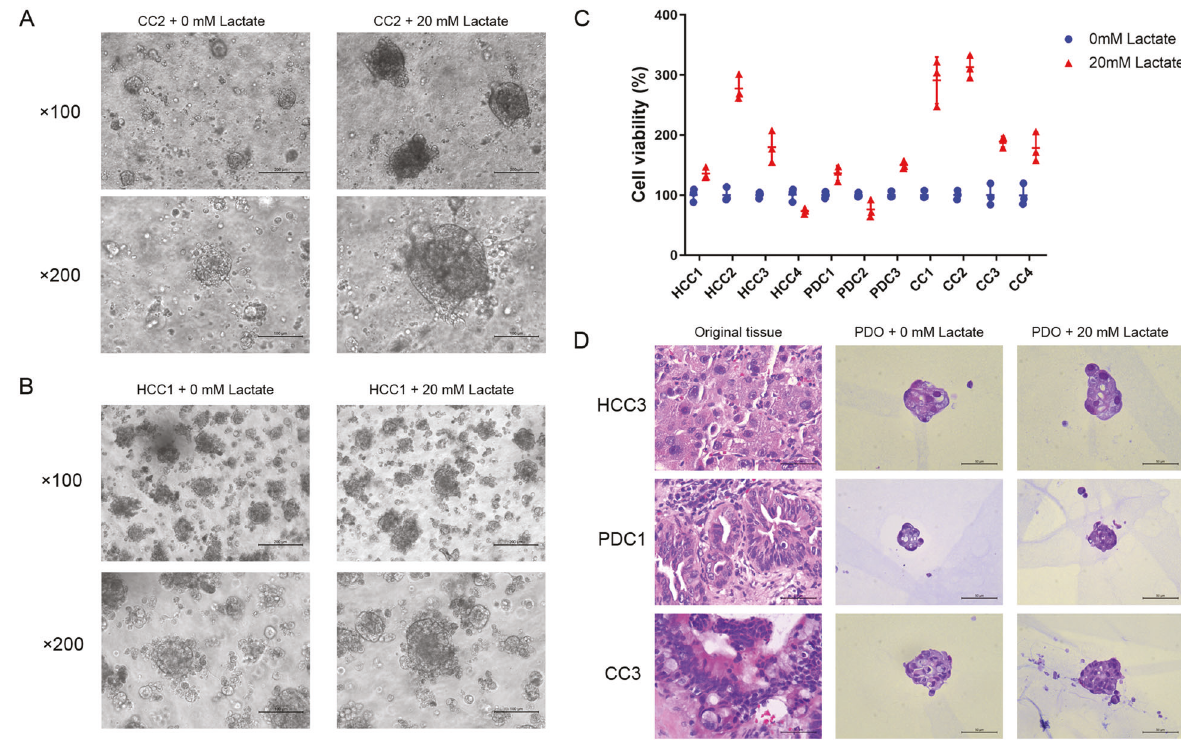
Fig. 3 Lactate promoted the growth of PDOs from hepatopancreatobiliary tumors and preserved their pathological structure. A Bright- fi eld images of CC2 PDO without or with 20 mM lactate treatment. Scale bars in ×100 row refer to 200 μ m and scale bars in ×200 row refer to 100 μ m. B Bright- fi eld images of HCC1 PDO without or with 20 mM lactate treatment. Scale bars in ×100 row refer to 200 μ m and scale bars in ×200 row refer to 100 μ m. C Viability of 11 PDOs without or with 20 mM lactate treatment. D Representative images of HE-stained tumor tissues, and the HCC3, PDC1, and CC3 PDOs treated as indicated. Scale bar: 50 μ